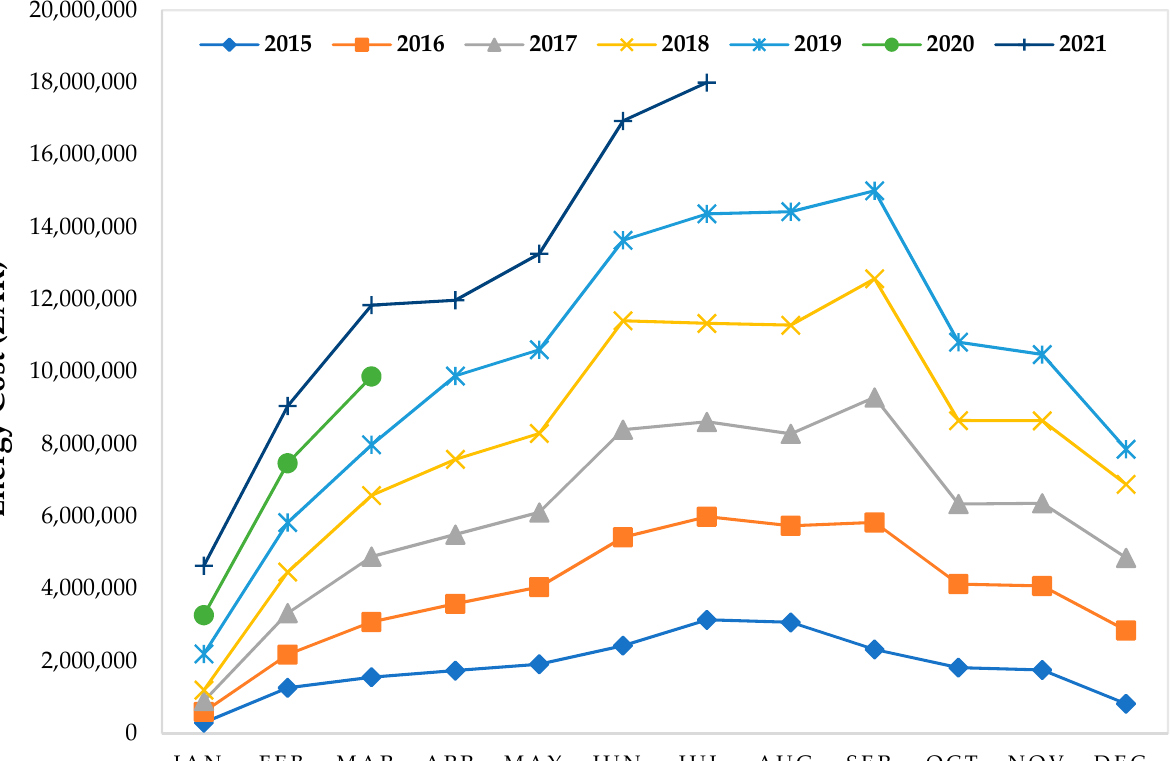
Figure 6. UJ-Res total monthly energy cost (in ZAR) from January 2015 to July 2021.